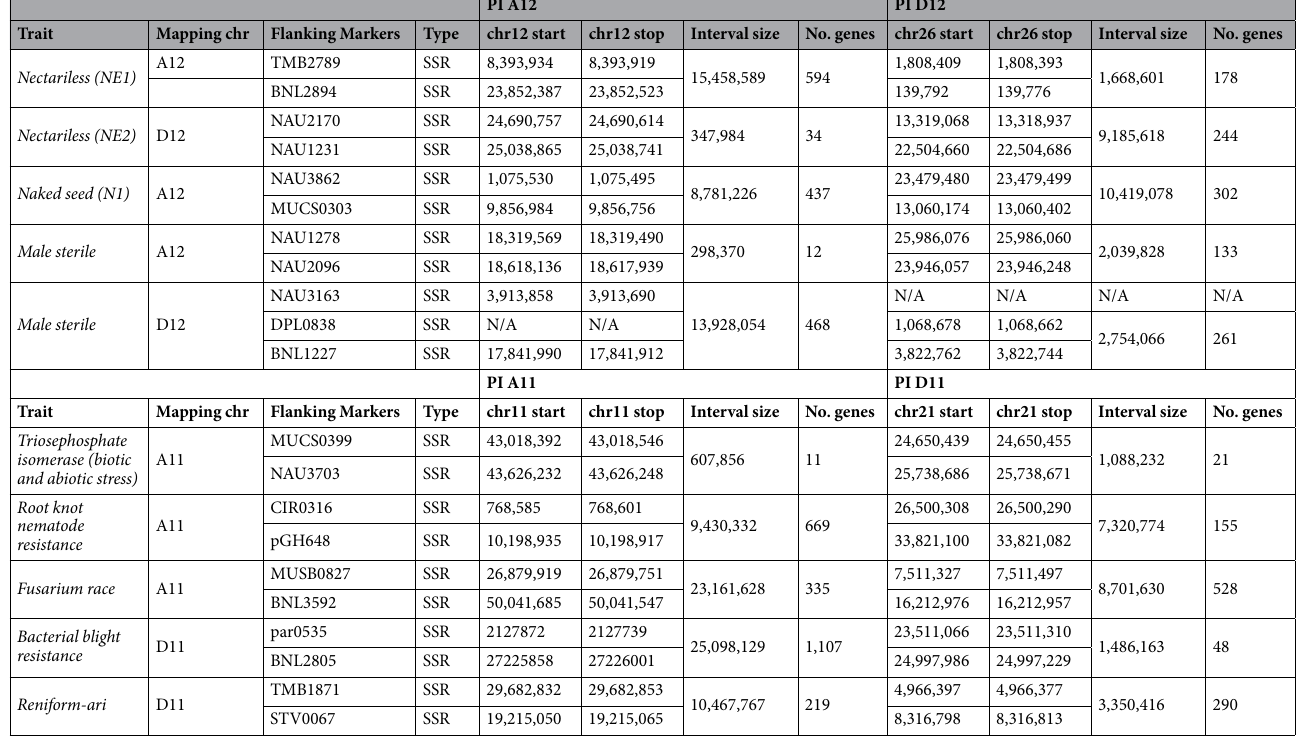
Table 4. QTL markers aligned to BAC-based assemblies of A12/D12 and